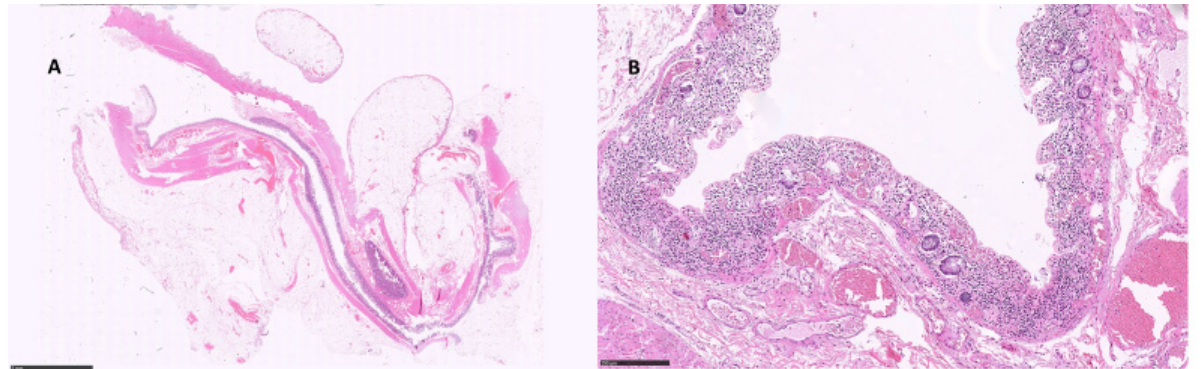
Figure 4. Ischemic colitis (intestinal perforation): ( A ) distal colon, showing flattened mucosa and thinned wall, 6×; ( B ) ischemic changes, consisting of extensively necrotic mucosa and neutrophilic infiltrate with blood vessels ectasia, 25× (hematoxylin and eosin).